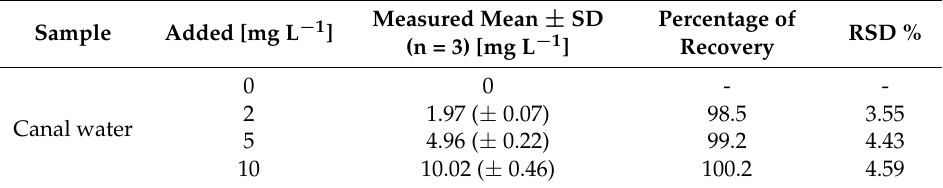
Table 4. The percentage of recoveries (R) of real canal water samples spiked with the